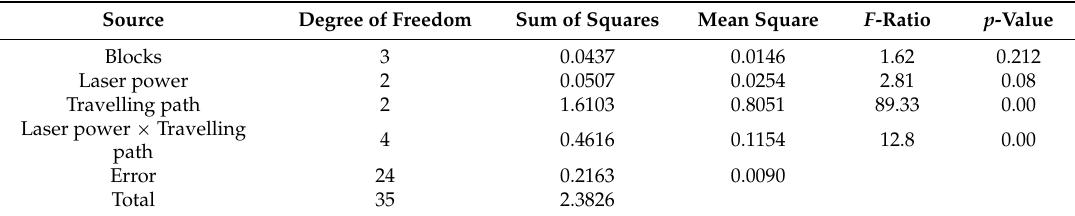
Table 13. ANOVA table for experiment #2-2 (6-kW disk laser welding system). Source Degree of Freedom Sum of Squares Mean Square F -Ratio p -Value Blocks